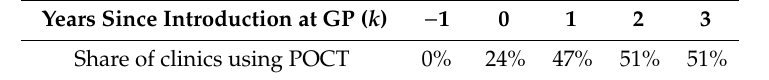
Table 4. POCT clinic shares of diabetes patients receiving POCT after flexible